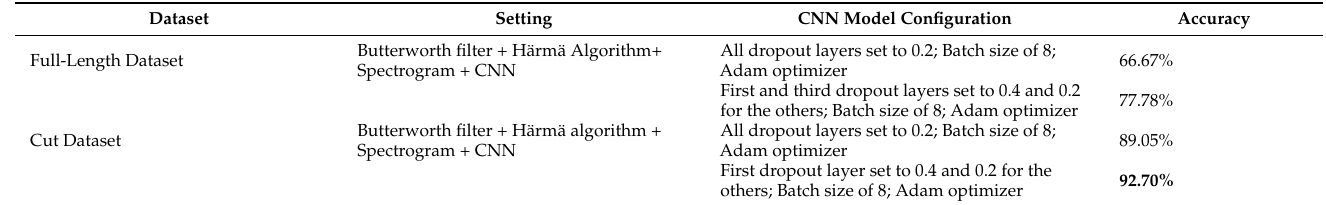
Table 2. Experimental results using the Härmä